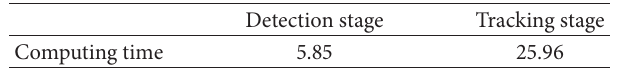
Table 4: Computing time (Unit: